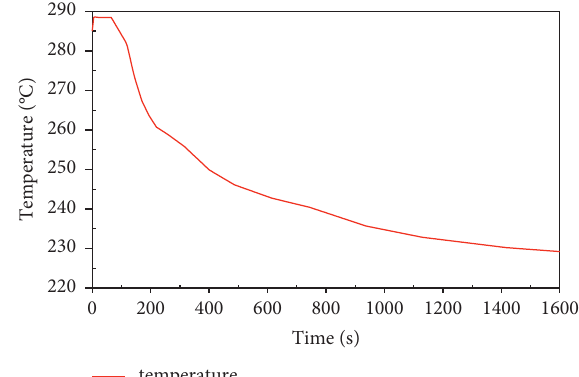
Figure 11: Temperature variation at the maximal stress concen- tration area in the FE vessel model during the PTS transient.